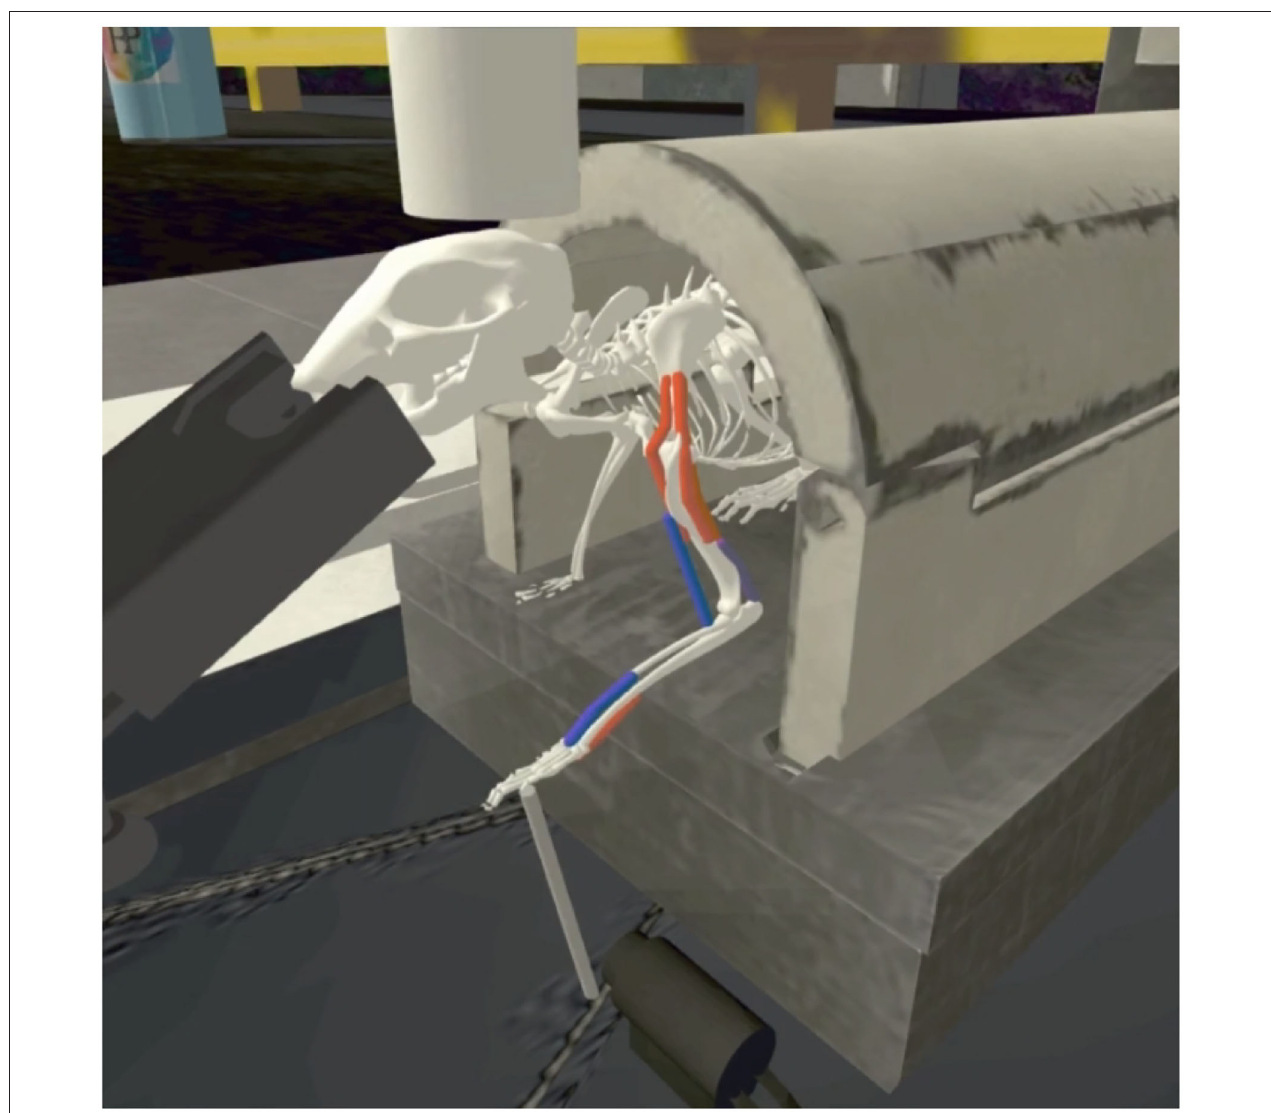
FIGURE 6 | Model simulation in the Neurorobotics Platform: The musculoskeletal rodent model and experiment platform setup were modeled or adapted and aggregated with the Robot Designer. After exporting the model, it was simulated in the Neurorobotics Platform, and individual muscles could be controlled independently via ROS topics (active: red, inactive: